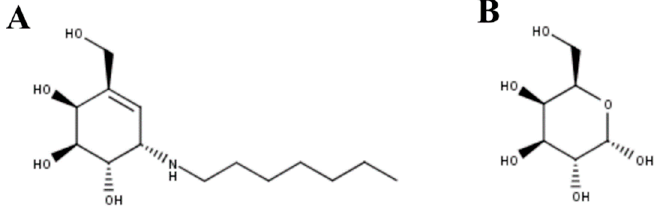
Figure 2. ( A ) N-octyl-4-epi- β -valienamine (NOEV) and ( B ) galactose were the first PCs described for GLB1 deficiency.